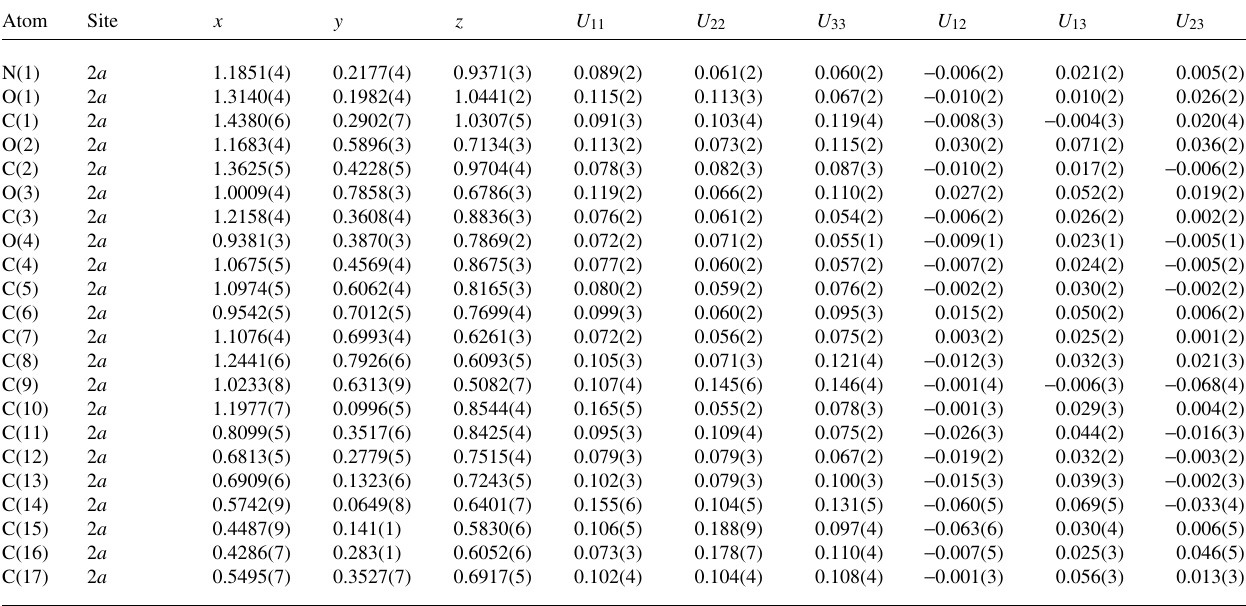
Table 3. Atomic coordinates and displacement parameters (in Å 2 ) .